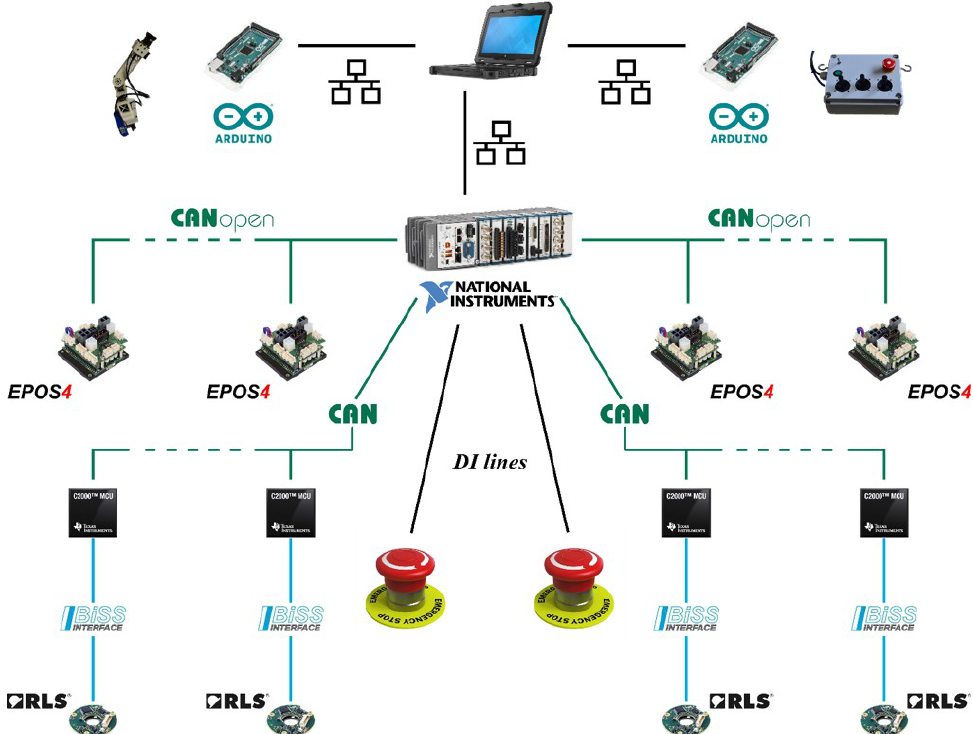
Figure 10. Electronic architecture of the